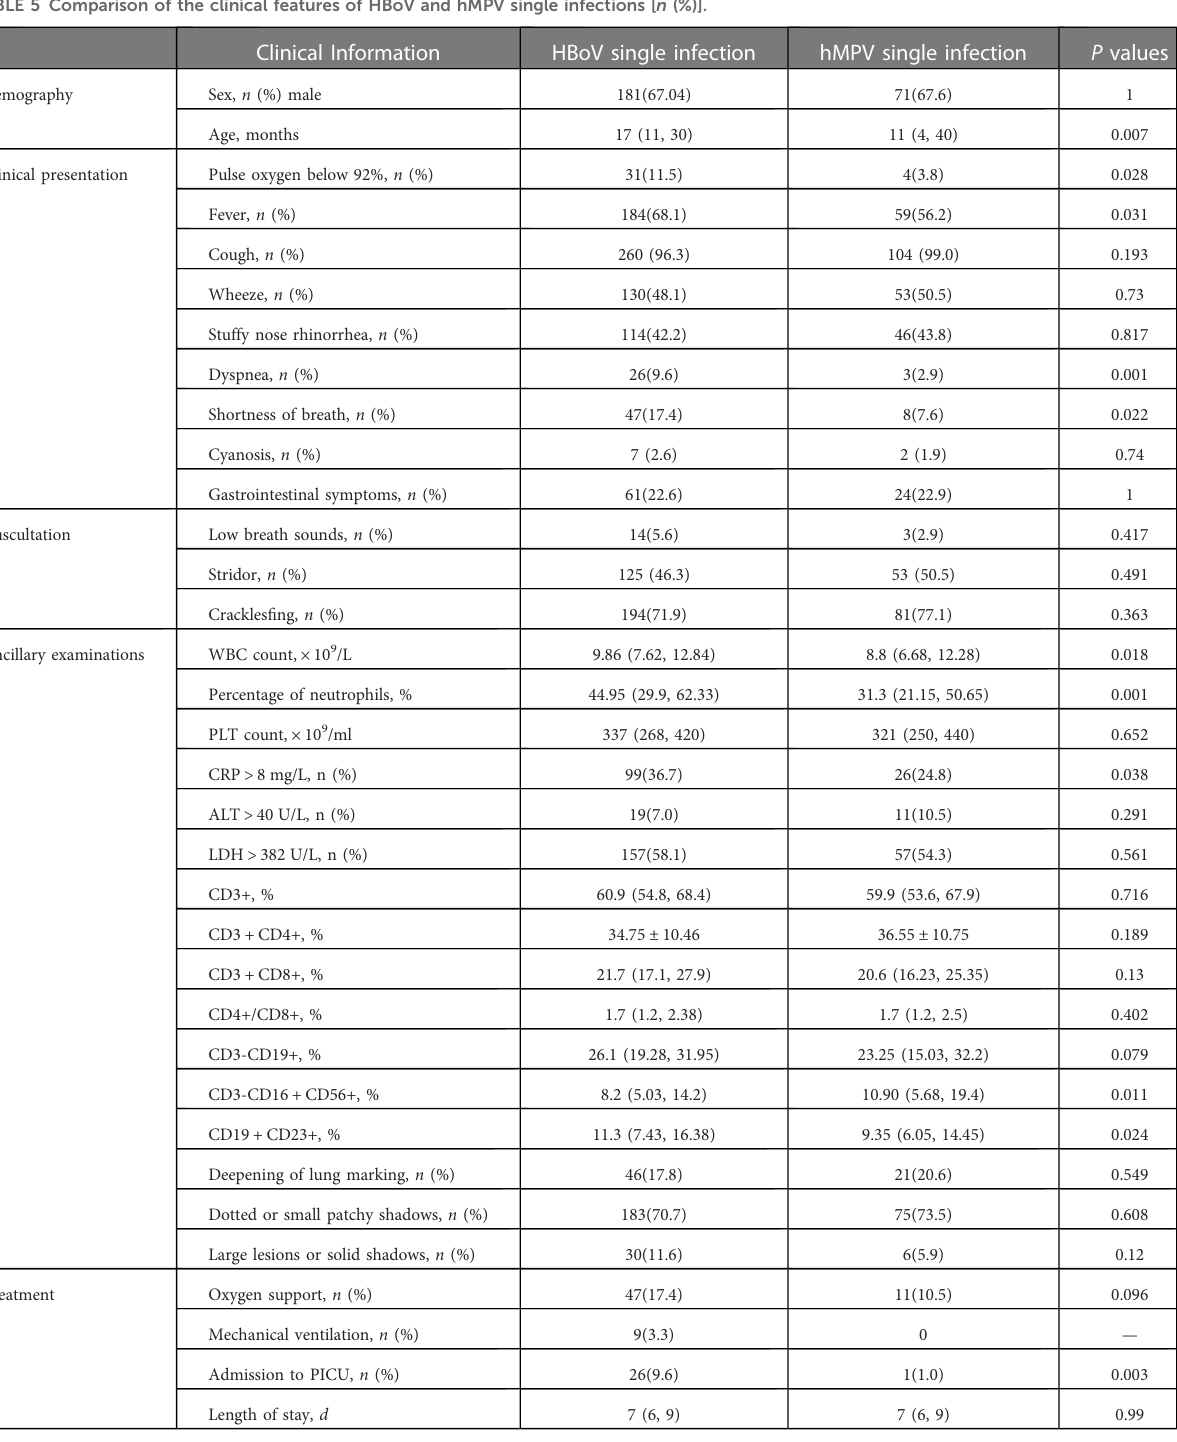
TABLE 5 Comparison of the clinical features of HBoV and hMPV single infections [ n